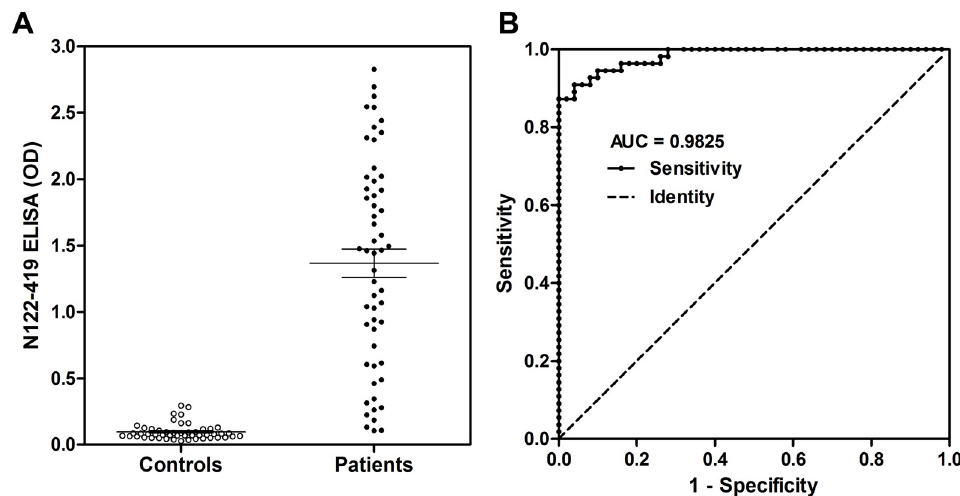
Fig 5. ELISA test is efficient for distinguishing between sera presenting antibodies against SARS-CoV-2 from those who do not. ROC curve results. A, Distribution of OD values from infected individuals and controls sample; B, Sensitivity and specificity rate for each cut-off point of the ROC curve and the AUC result.